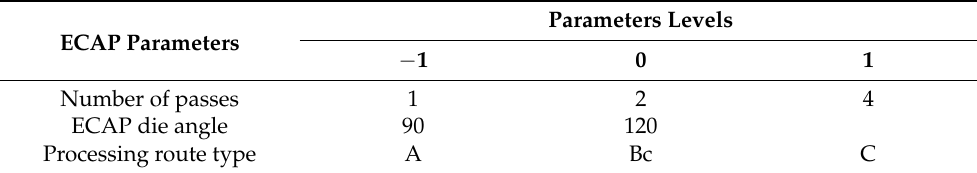
Table 1. ECAP parameters and corresponding levels. ECAP